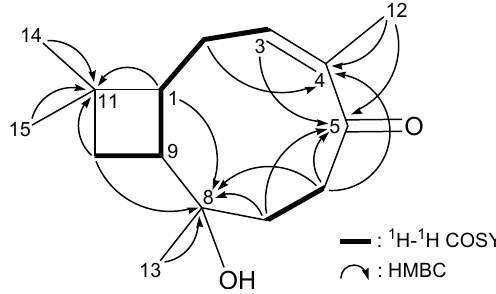
Figure 1. 1 H– 1 H COSY and selective HMBC correlations (protons → quaternary carbons) of 1 .